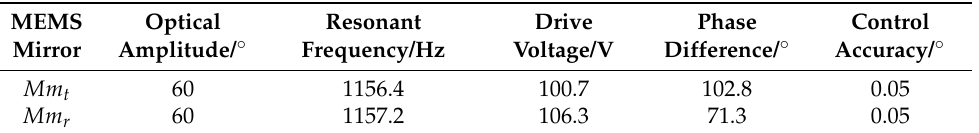
Table 1. Specifications of the MEMS mirror pair.